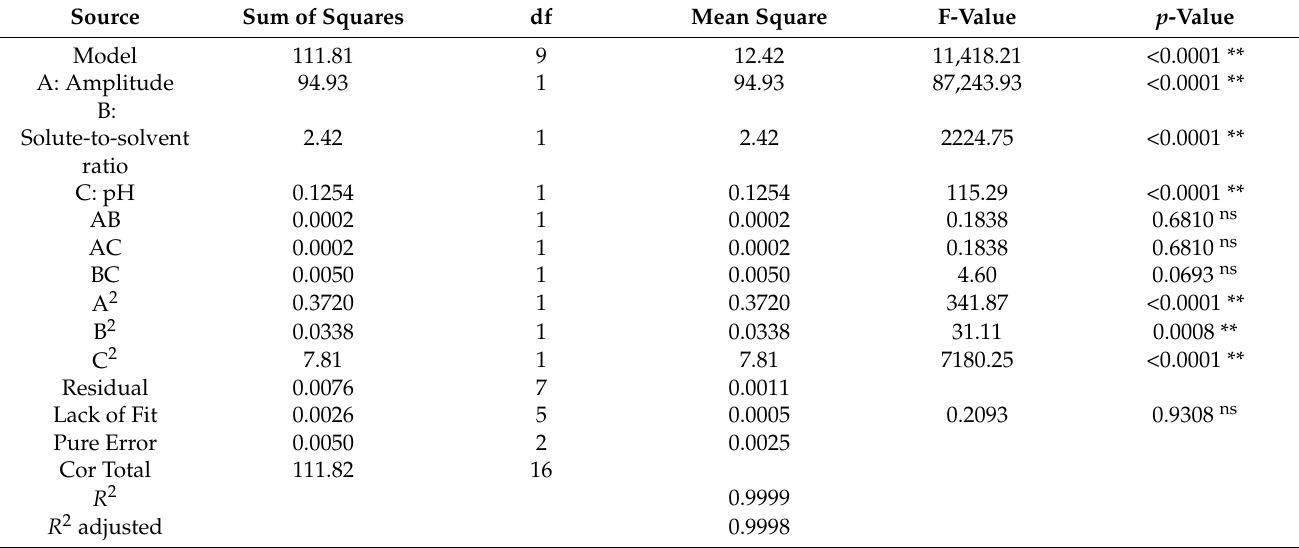
Table 2. Analysis of variance (ANOVA) for quadratic